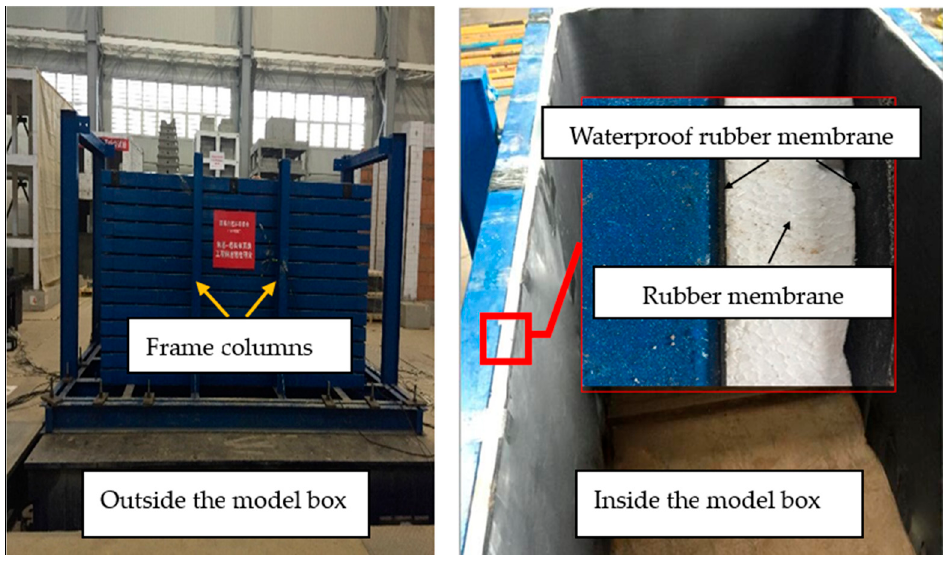
Figure 7. Laminar shear